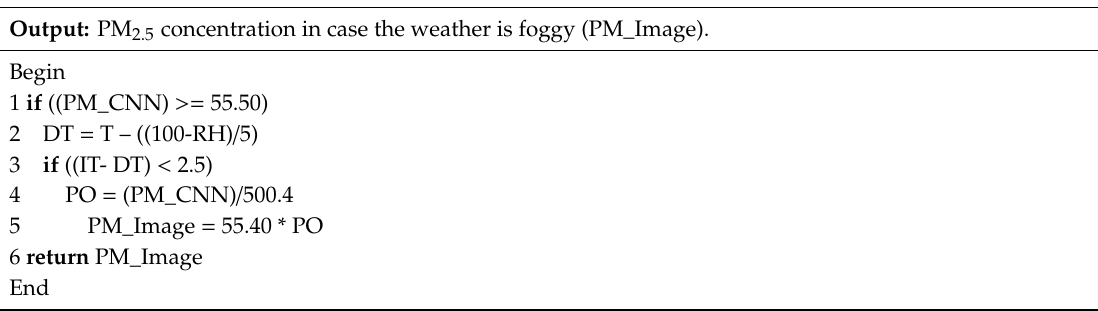
Algorithm 2: an algorithm to recalculate PM 2.5 in a foggy weather